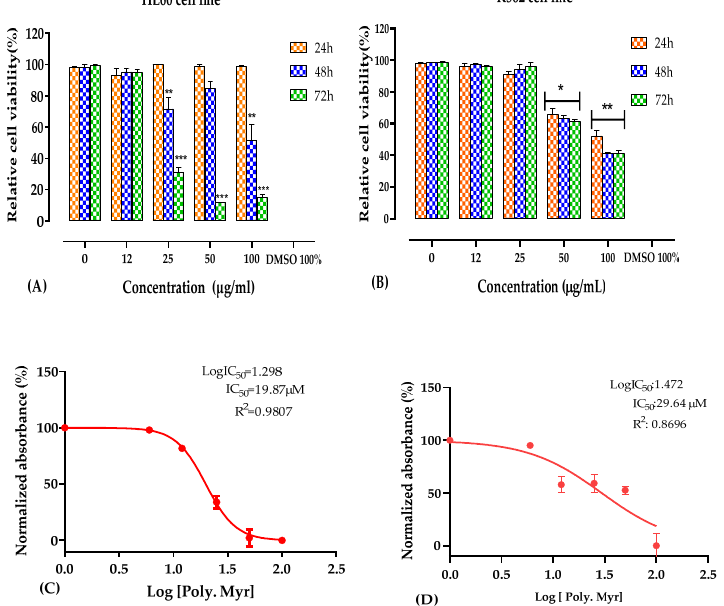
Figure 1. Cytotoxicity of the polyphenol-enriched fraction extracted from Myrtus communis for K562 and HL60 cells. ( A ) K562 and ( B ) HL60 cell viability after 24–72 h of treatment with different con- centrations of the PEMC (12–100 µg/mL). The IC 50 values for K562 ( C ) and HL-60 ( D ) were estimated using nonlinear regression. The absorbance values were measured at the wavelength of 570 nm, and the mean values ± SD of three experiments are displayed along with a representative IC 50 curve. The cell viability was estimated by the MTT assay. * p < 0.05; ** p < 0.01;*** p < 0.001.